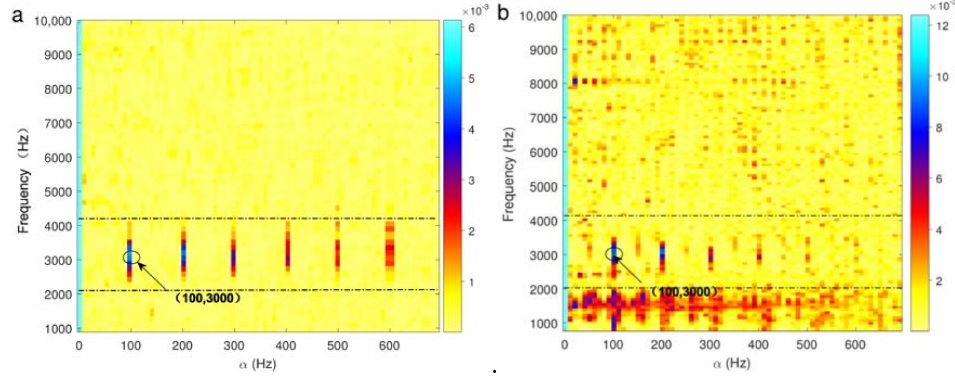
Figure 8. The MID SCoh ∆ of the decomposed BLIMF2 using VMD ( a ) and IMF3 using EMD ( b ). f A noise variance of 0.7 is set in the simulated signal in Figure 9. MID PSCoh ∆